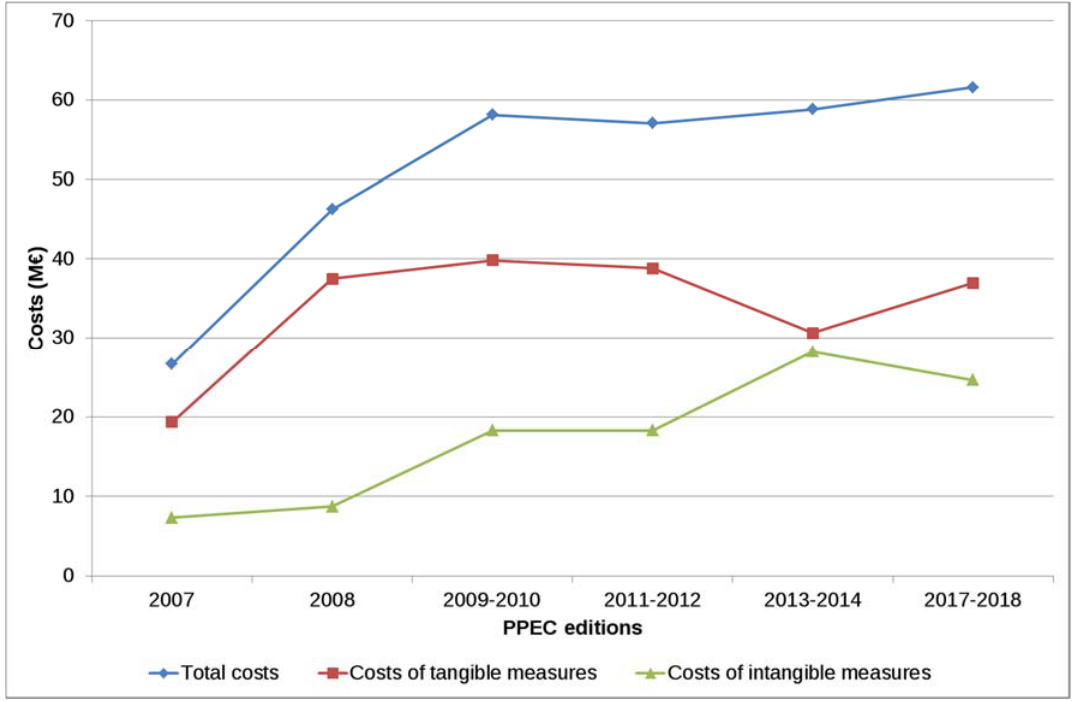
Figure 3. PA costs of the eligible measures throughout PPEC editions [19–25].